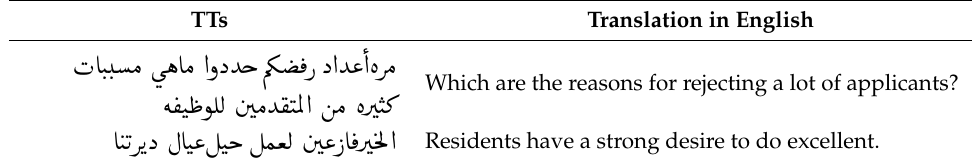
Table 6. Sample of TTs containing intensification.